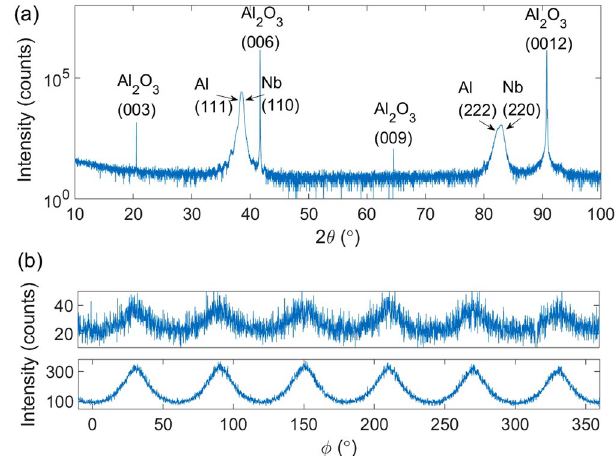
Figure 3. ( a ) High-resolution XRD pattern of the Al/Nb/Al trilayer film on the c-cut sapphire. ( b ) Azimuthal XRD data (“ φ -scan”) reveals the six-fold symmetry of the off-axis (200) reflections from Al and Nb,